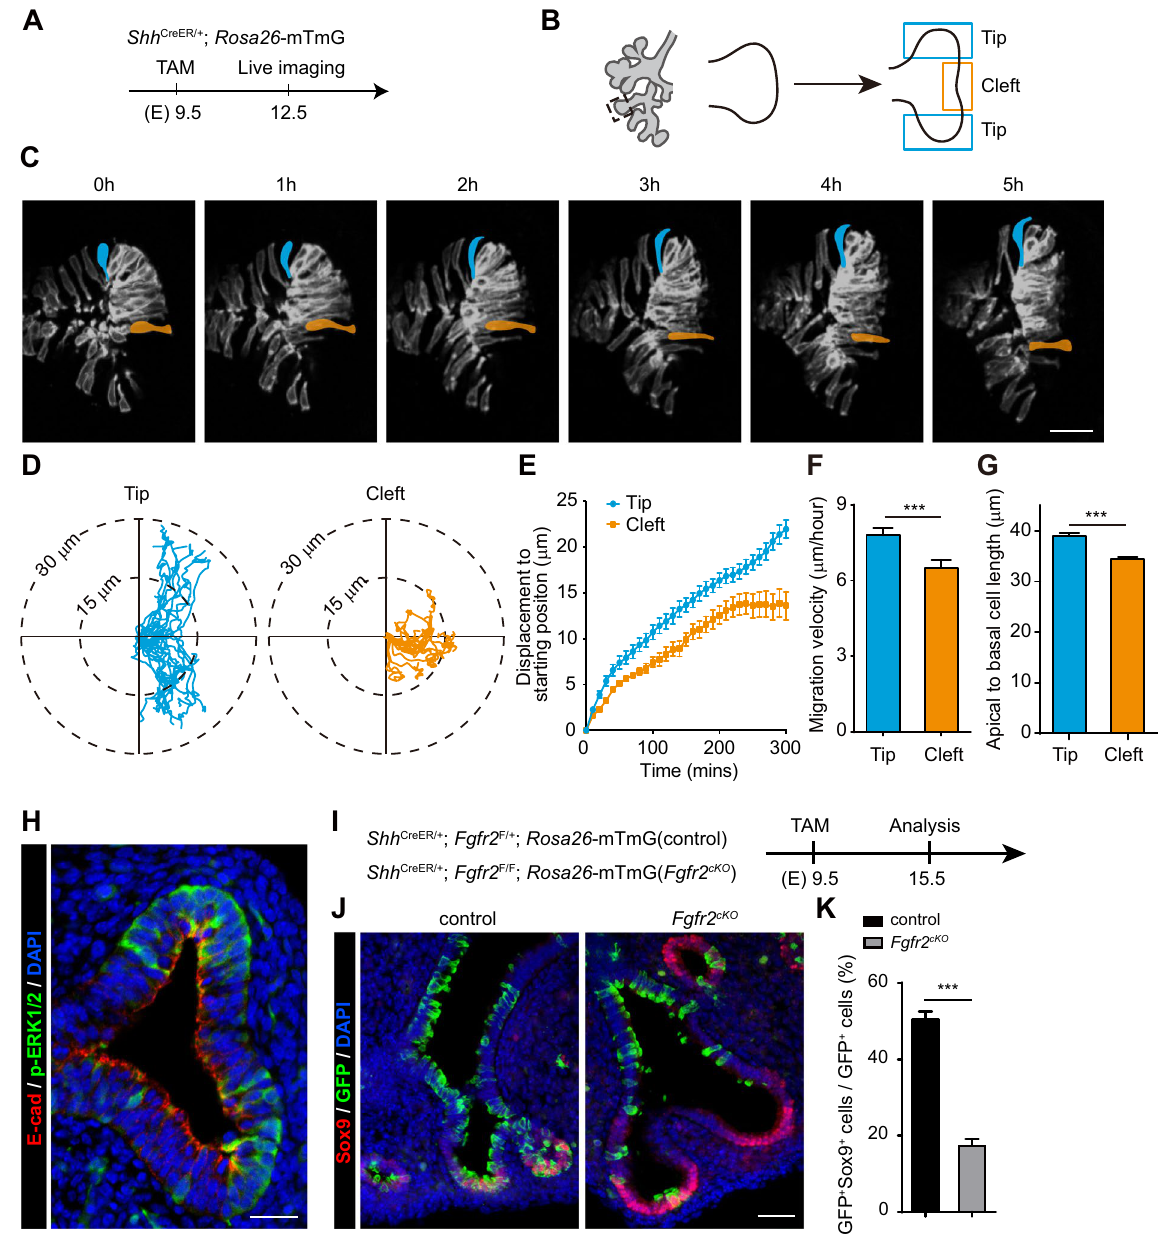
Figure 1. Airway progenitor cells that migrate faster tend to commit to distal airway cell fate. ( A – C ) Pregnant females carrying Shh CreER/ + ; Rosa26 -mTmG embryos were treated with tamoxifen (TAM) at E9.5 and lungs were imaged at E12.5 ( A ). Bud tip of the first lateral branch in right caudal lobe (RCd.L1) was imaged. Finally, two new bud tips were formed while the middle cells between two bud tips formed the cleft ( B ). After five- hour imaging, the tip cells (one cell was highlighted by blue) directly moved out and formed a new bud tip, while the middle cells (one cell was highlighted by orange) moved slower and tended to lag behind ( C ). Scale bar: 50 μ m. ( D – G ) Cell track plots of tip cells (24 cells) and cleft cells (17 cells) after aligning their starting positions ( D ), showing that tip cells can migrate longer than cleft cells ( D , E ); The migration velocity analysis showed that tip cells migrate faster than cleft cells ( F ); and the tip cells have longer apical-to-basal cell length ( G ). Data are presented as mean ± SEM; n = 3 live image samples; *** p < 0.001; Student’s t -test. ( H ) WT lung bud at E12.5 was analyzed by E-cadherin (red) and p-ERK1/2 (green) immunostaining. The bud tips showed higher p-ERK1/2 staining compared to cleft cells. Scale bar: 25 μ m. ( I – K ) Pregnant females carrying Shh CreER/ + ; Fgfr2 F/ + ; Rosa26 -mTmG (control) and Shh CreER/ + ; Fgfr2 F/F ; Rosa26 -mTmG ( Fgfr2 cKO ) embryos were treated with tamoxifen (TAM) at E9.5 and lungs were sampled at E15.5 ( I ). Immunostaining using antibodies against GFP and Sox9 showed that less GFP + Sox9 + cells were detected in Fgfr2 cKO lung as compared to control lung ( J , K ). Data are presented as mean ± SEM; *** p < 0.001; Student’s t -test. Scale bar: 25 μ